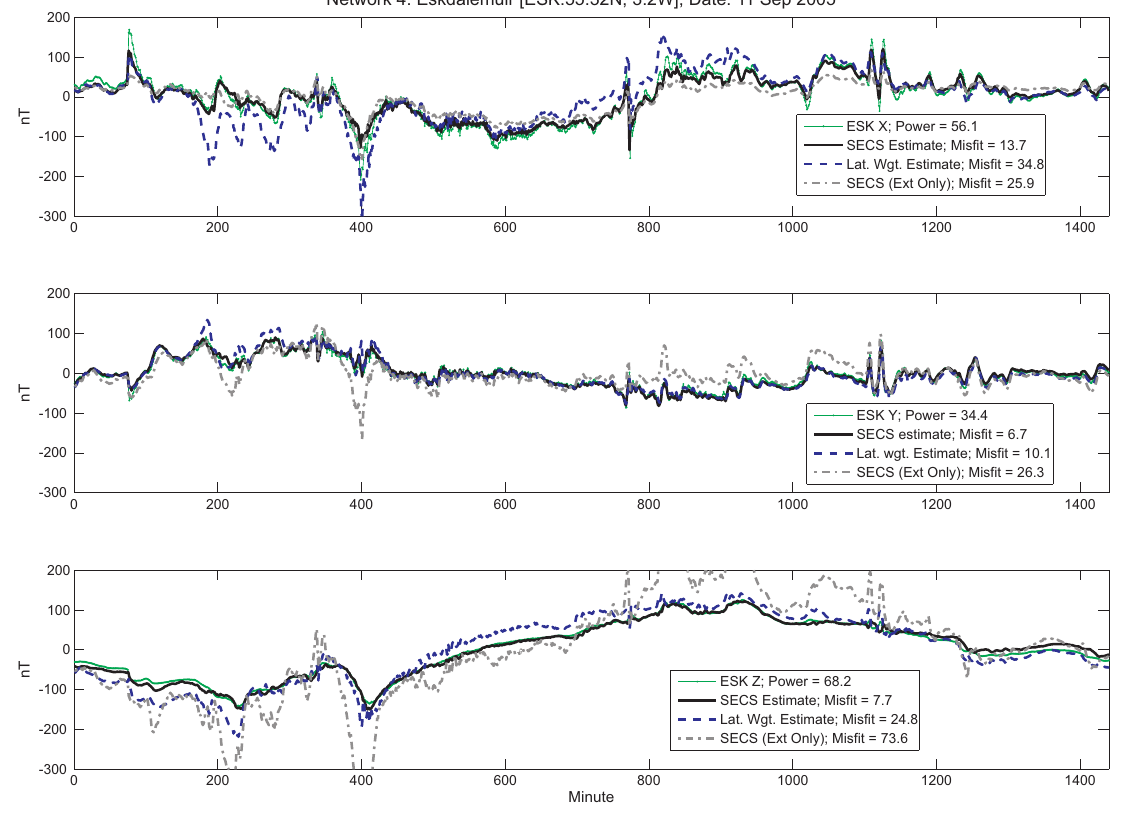
Fig. 3. Comparison of the measured external field disturbance (green solid, dots) and the estimate from SECS (black solid), Latitudi- nal Weighted (blue dashed) and SECS (External only) (grey dot-dash) at magnetic observatory Eskdalemuir (ESK) during a magnetically disturbed day (11 September 2005). Power and RMS misfit are in nT. Y-axis scaled to show finer